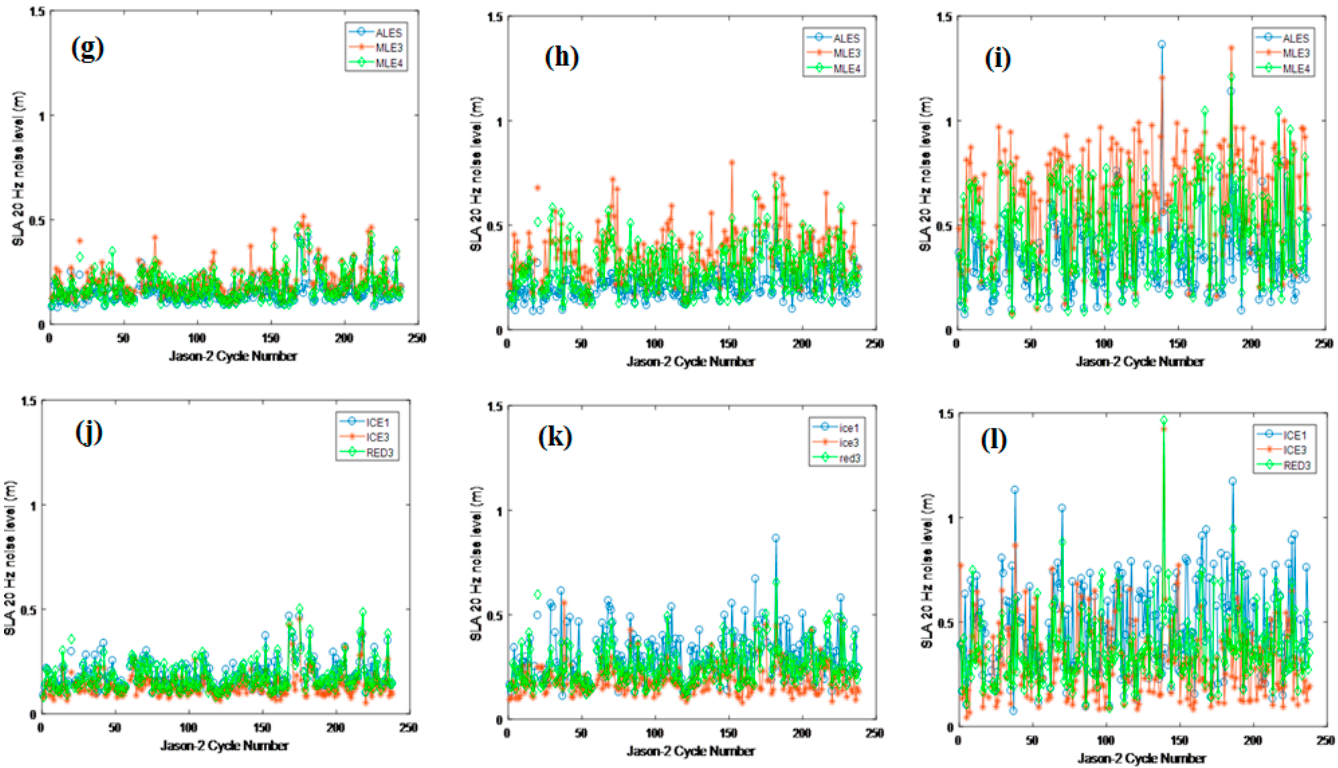
Figure 10. SLA means and noise levels. ( a ) Case 1, mean SLA for ALES, MLE3 and MLE4; ( b ) Case 2, mean SLA for ALES, MLE3 and MLE4; ( c ) Case 3, mean SLA for ALES, MLE3 and MLE4; ( d ) Case 1, mean SLA for ICE1, ICE3 and RED3; ( e ) Case 2, mean SLA for ICE1, ICE3 and RED3; ( f ) Case 3, mean SLA for ICE1, ICE3 and RED3; ( g ) Case 1, noise levels for ALES, MLE3 and MLE4; ( h ) Case 2, noise levels for ALES, MLE3 and MLE4; ( i ) Case 3, noise levels for ALES, MLE3 and MLE4; ( j ) Case 1, noise levels for ICE1, ICE3 and RED3; ( k ) Case 2, noise levels for ICE1, ICE3 and RED3; ( l ) Case 3, noise levels for ICE1, ICE3 and RED3.